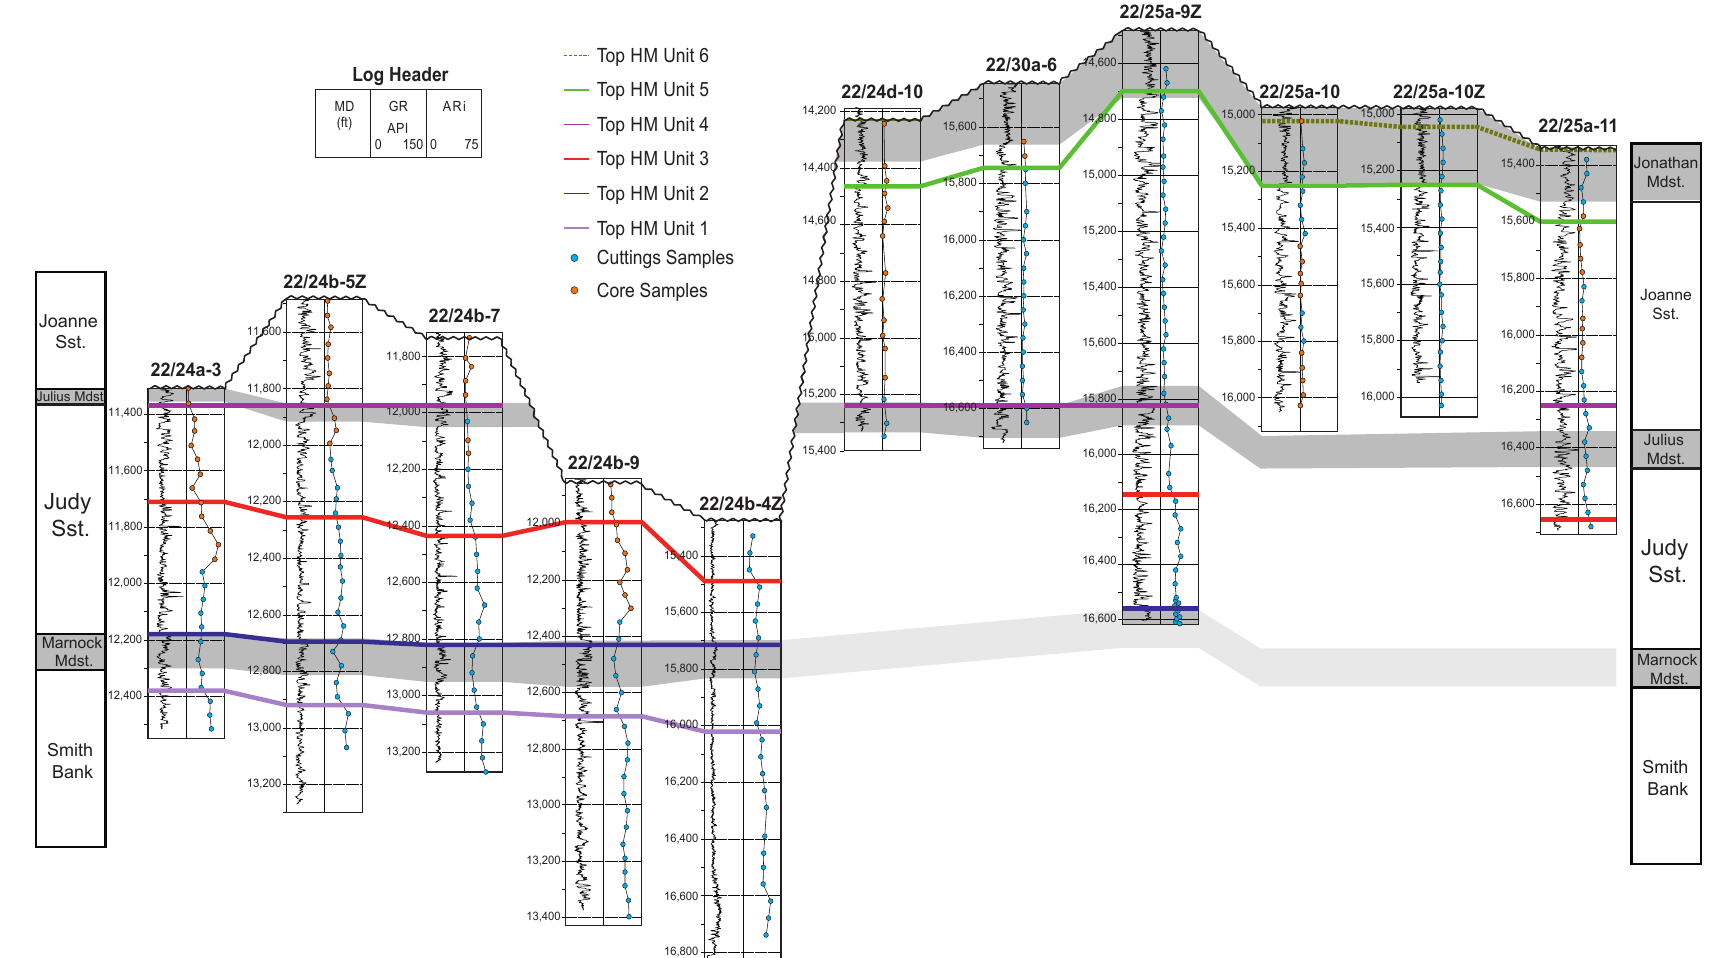
Figure 7. Semi-regional correlation of the Triassic in UK quadrant 22, central North Sea, using variations in apatite morphology [48]. For well locations, see Figure